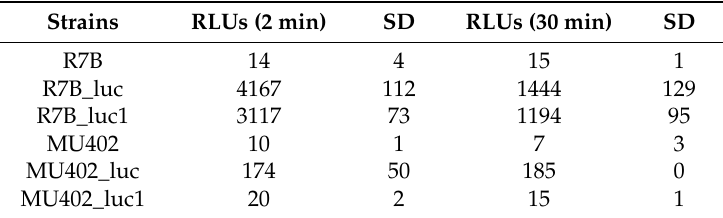
Table 2. Detection of luminescence signal by microplate reader. 10 5 spores/mL of the respective strains were grown in YNB medium (containing supplements where needed) for 24 h. Light emission was induced by the addition of D-luciferin (10 mM) and detected with a microplate reader (Tecan Group AG, Männedorf, Switzerland). Ten seconds were set as integration time. Measurements were carried out 2 min and 30 min after substrate addition. RLUs (relative light units) present the average of three experiments; SD represents standard deviation. Strains RLUs (2 min) SD RLUs (30 min) SD R7B 14 4 15 R7B_luc 4167